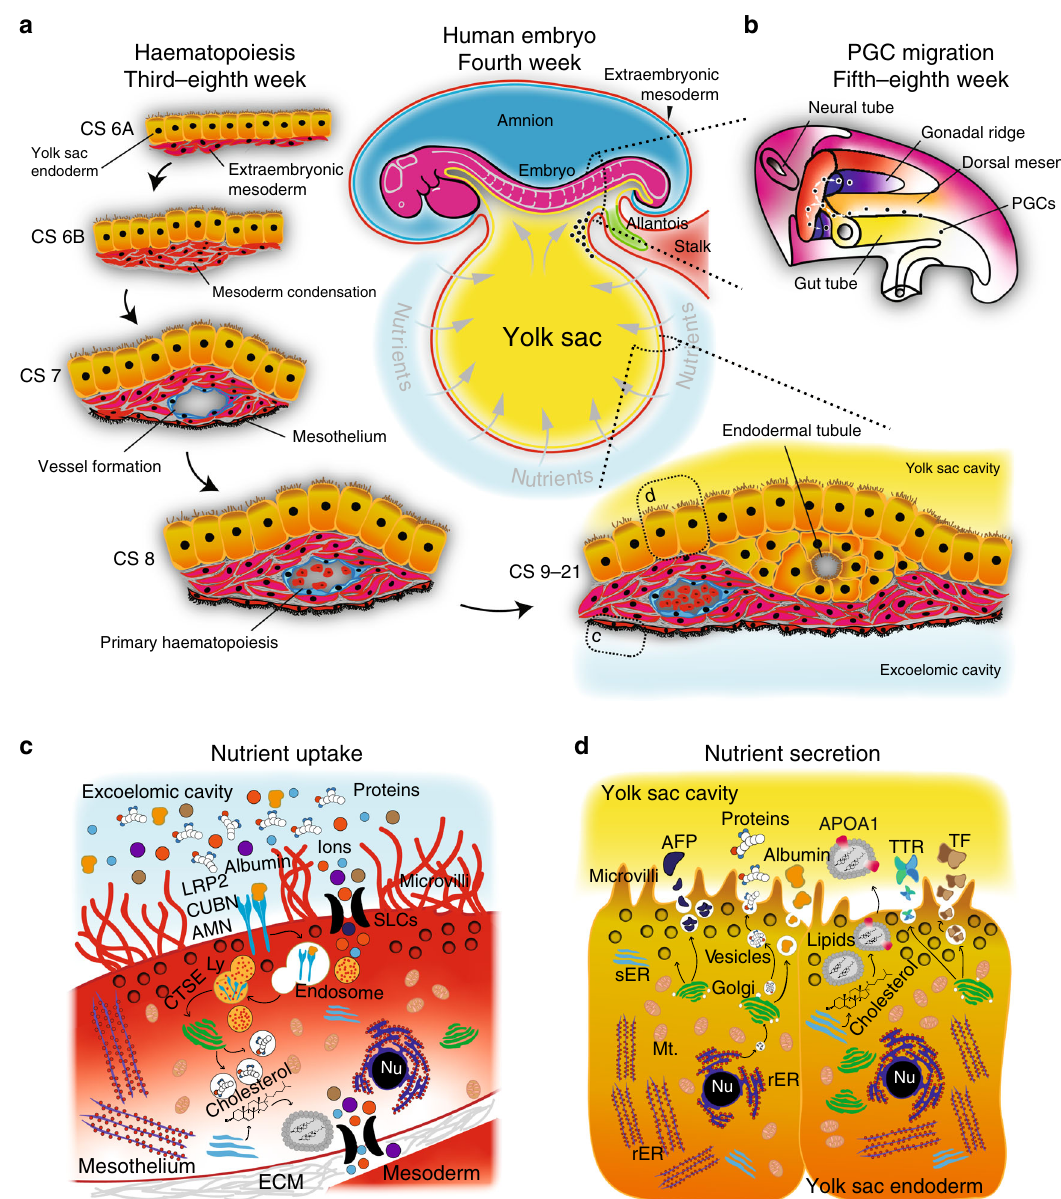
Fig. 5 Functions of the primate secondary yolk sac. a Vasculogenesis of the yolk sac forms an intricate vascular plexus that envelopes the yolk sac from Carnegie stage (CS) 6A. Haematopoiesis ensues in preparation for the onset of embryonic circulation, mediated by the developing heart. Reciprocal crosstalk signalling between the endoderm and mesoderm regionalises foci of condensed mesoderm, which form primitive blood islands. b PGCs are speci fi ed in the embryonic region and migrate via the yolk sac into the hindgut and up through the dorsal mesentery towards the genital ridges. Schematic drawn after ref. 164 . The original images were published in Medical Physiology E-Book 164 , Copyright Elsevier (Health Sciences, ISBN 1455733288, 9781455733286). c The mesothelium exhibits hallmarks of absorption, degradation and re-synthesis, evident by high concentration of LRP2 – CUBN – AMN endovesicular complexes in the plasma membrane. Lysosomes contain hydrolytic enzymes, such as the Cathepsins, to mediate the degradation of maternal proteins and other complex molecules in the nutrient-rich exocoelomic cavity. Nutrients are either transported or re-synthesised and exocytosed either directly into surrounding blood vessels or transported through the extracellular environment towards the endodermal tubules and the yolk sac cavity. d The endoderm contains high concentrations of rER, sER, glycogen vesicles and exocytotic vesicles. Yolk sac endoderm cells synthesise and exocytose key carrier proteins such at AFP, TTR, ALB and TF into the yolk sac cavity, which are absorbed by primitive gut endoderm. Nu nucleus, rER rough endoplasmic reticulum, sER smooth endoplasmic reticulum, Mt Mitochondrion, SLC solute carrier family, Ly lysosome, CTSE Cathepsin family member E, LRP2 LDL- related receptor 2, CUBN Cubulin, ApoA apolipoprotein A, TTR transthyretin, TF transferrin, AFP alpha-fetoprotein, AMN